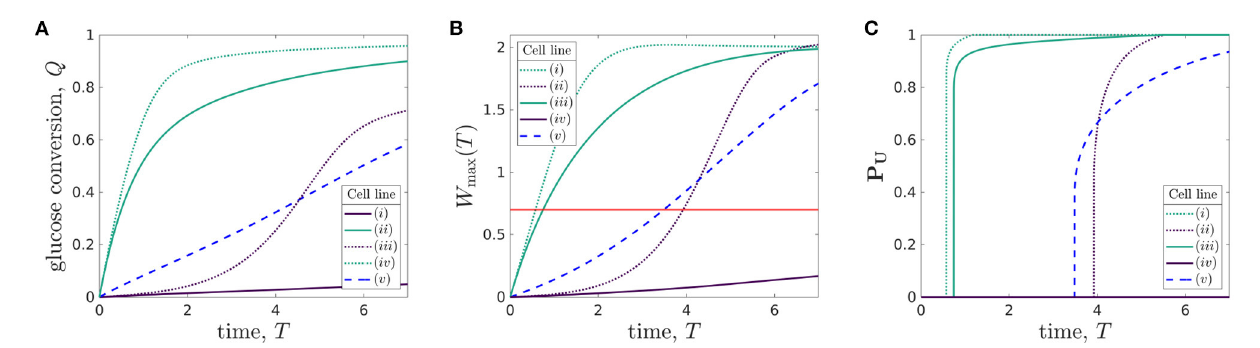
FIGURE 7 | Comparison of (A) glucose conversion Q , Eqaution (3.3), (B) maximum lactate concentration W max ( T ), Equation (3.2), where the red line represents the maximum tolerated lactate concentration, W = W tol , and (C) proportion of domain which is uninhabitable at time T , P U , Equation (3.4), for different organoid lines cultured within the bioreactor under the same operating conditions. The proliferation rates and rate of glucose consumption per cell for each organoid line are: (i) p = 1 / 6, ρ = 0.027, (ii) p = 1 / 6, ρ = 2.7, (iii) p = 1, ρ = 0.027, (iv) p = 1, ρ = 2.7, and (v) p = 1 / 3, ρ = 0.27. The other parameters used are given in Table 3 . The line styles correspond to rate of cellular proliferation: solid, P = 1 / 6; dashed, P = 1 / 3; and dotted, P = 1. The line colours correspond to rate of glucose consumption per cell density: purple, ρ = 0.027; blue, ρ = 2.7; and green, ρ = 2.7.